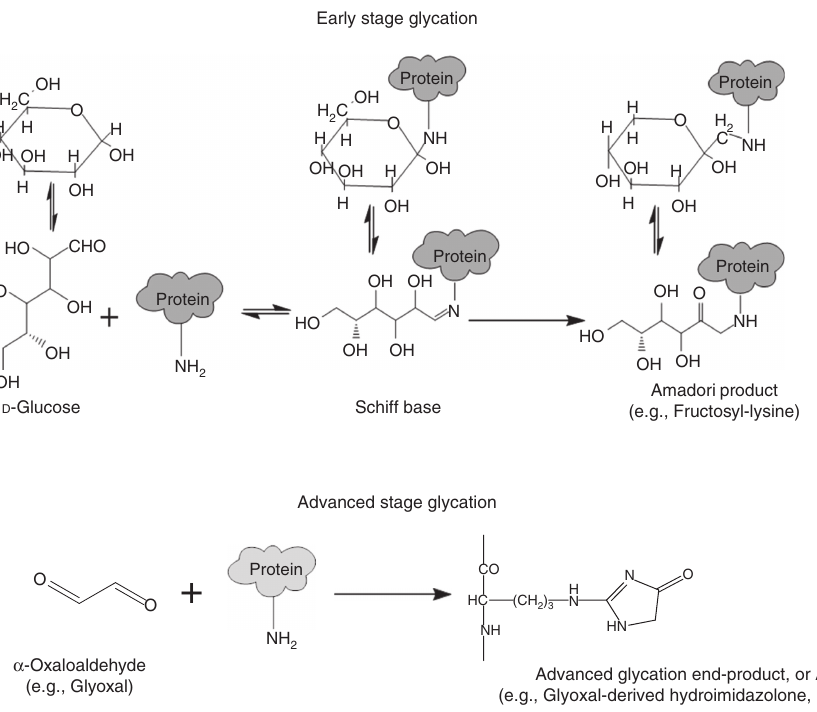
Figure 3 General reactions involved in the glycation of HSA, including both early-stage glycation (e.g., as illustrated through the forma- tion of fructosyl-lysine in the presence of glucose) and advanced-stage glycation (e.g., as illustrated in the formation of an AGE through the reaction of α -oxaloaldehyde with HSA) (Anguizola et al. 2013a). Copyright 2013 Elsevier and reproduced with